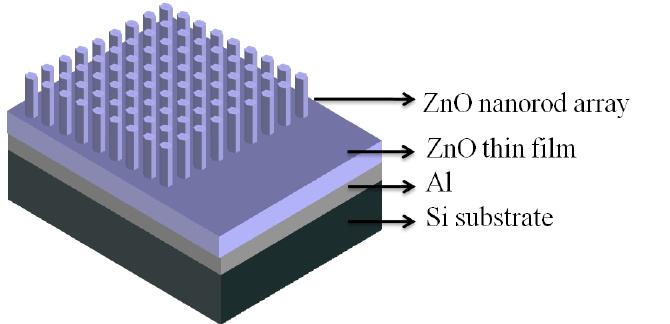
Figure 1. The schematic configuration of ZnO nanorod glucose